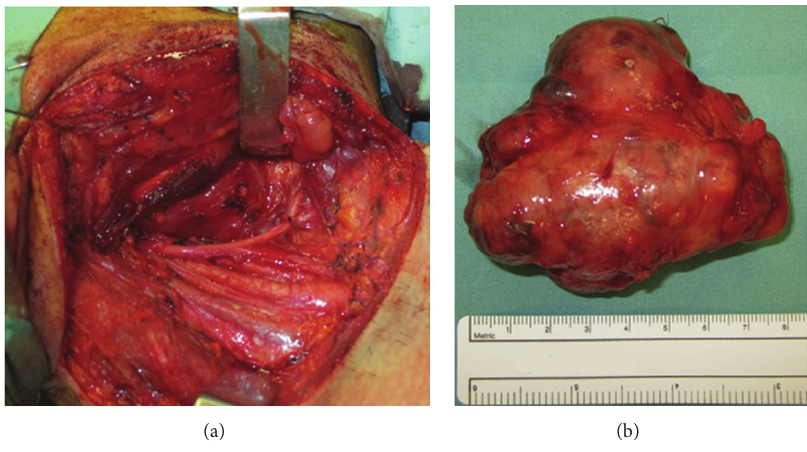
Figure 2: (a) The transcervical exposure of the tumour is demonstrated. (b) The excised specimen.